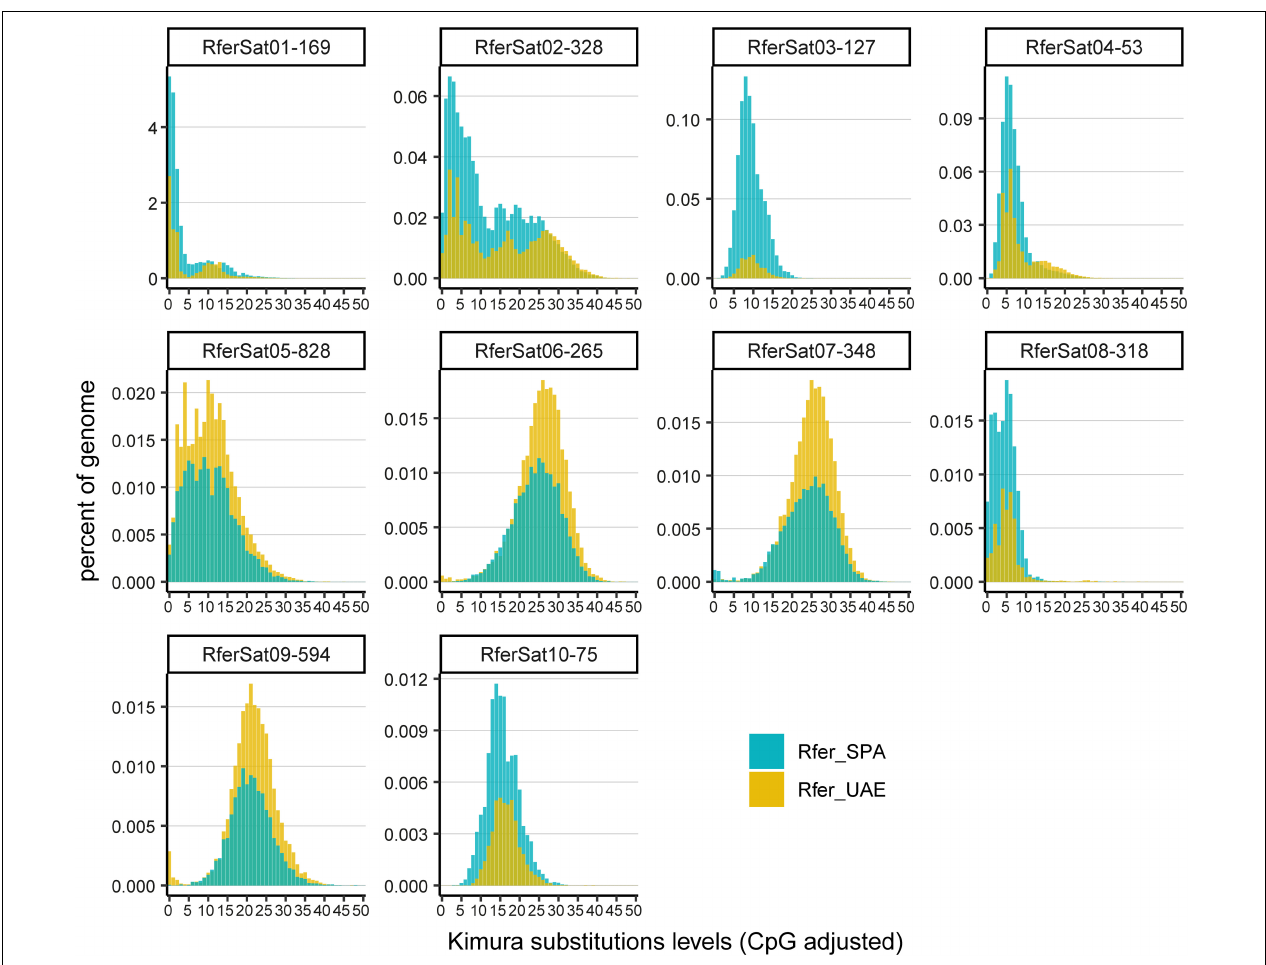
FIGURE 3 | Satellite landscape of most abundant satDNA